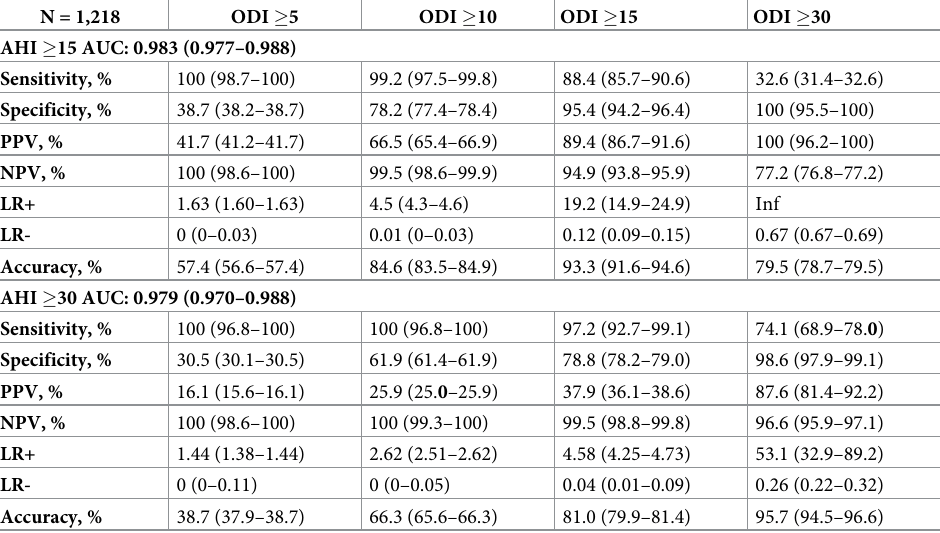
Table 3. Predictive parameters of oxygen desaturation index (ODI) at different cut-offs of apnea-hypopnea index